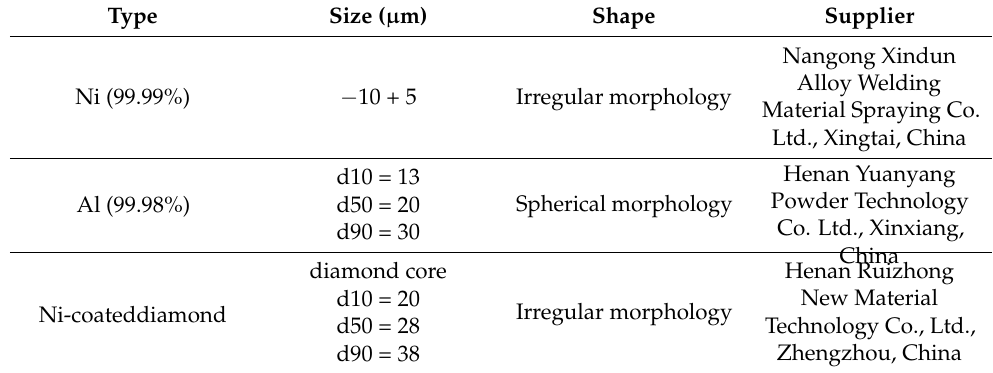
Table 1. Composition of feedstock for cold